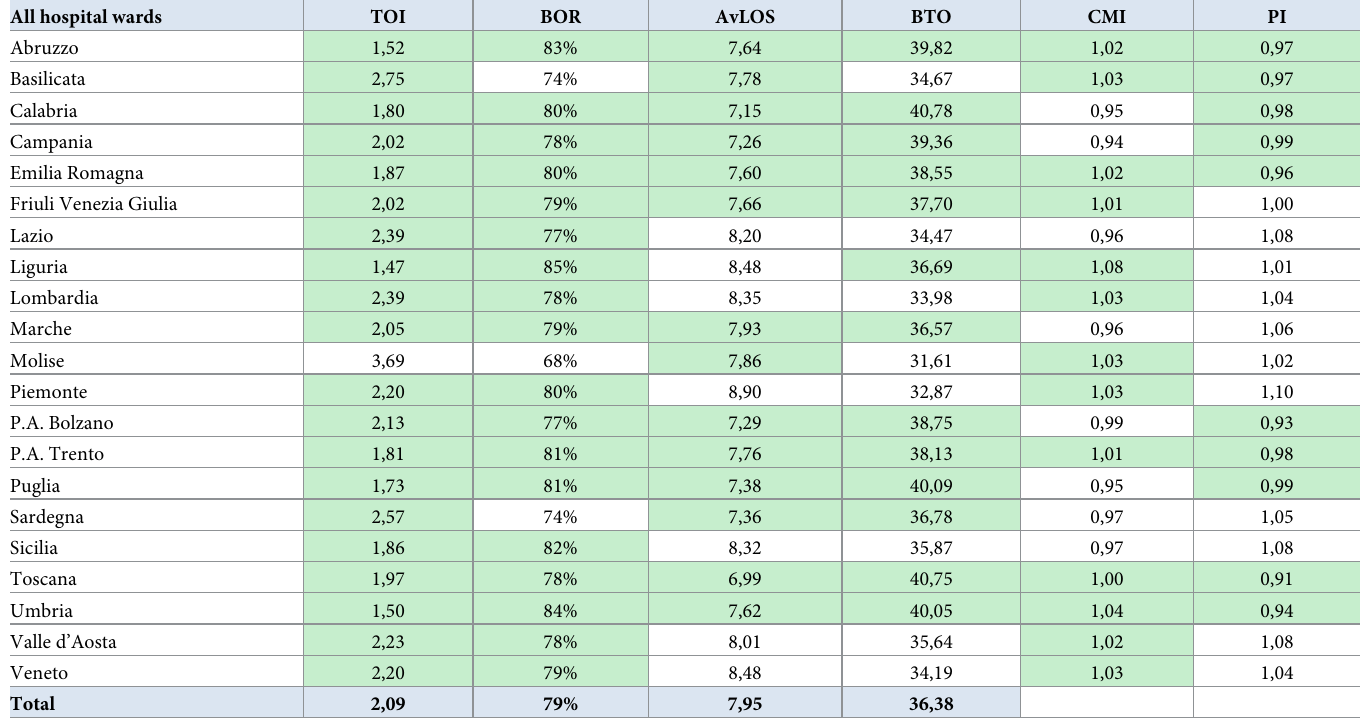
Table 4. Cross-regional comparison of the results of bed management as well as complex and performance analysis. All hospital wards